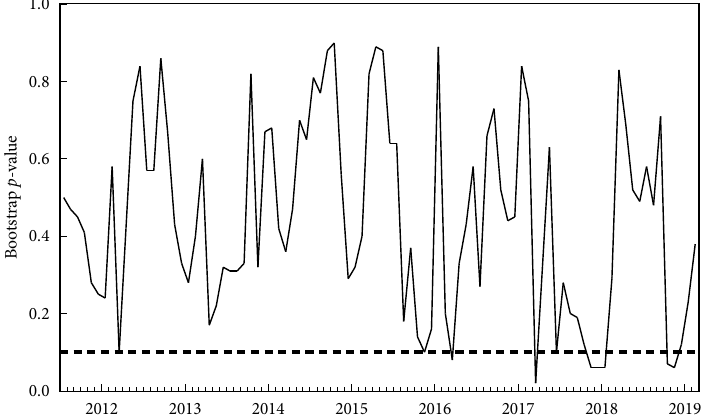
Figure 4. Bootstrap p -values of rolling test statistic testing the null hypothesis that BP does not Granger cause